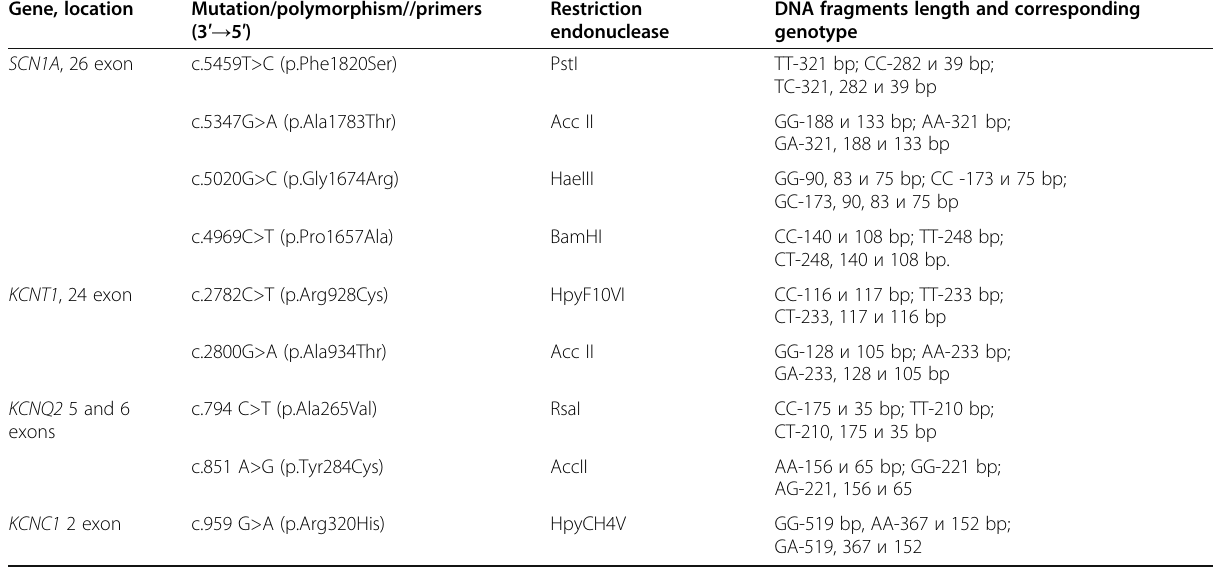
Table 2 Restriction endonucleases and SNV specific RFLP details Gene, location Mutation/polymorphism//primers (3 ′ → 5 ′ )